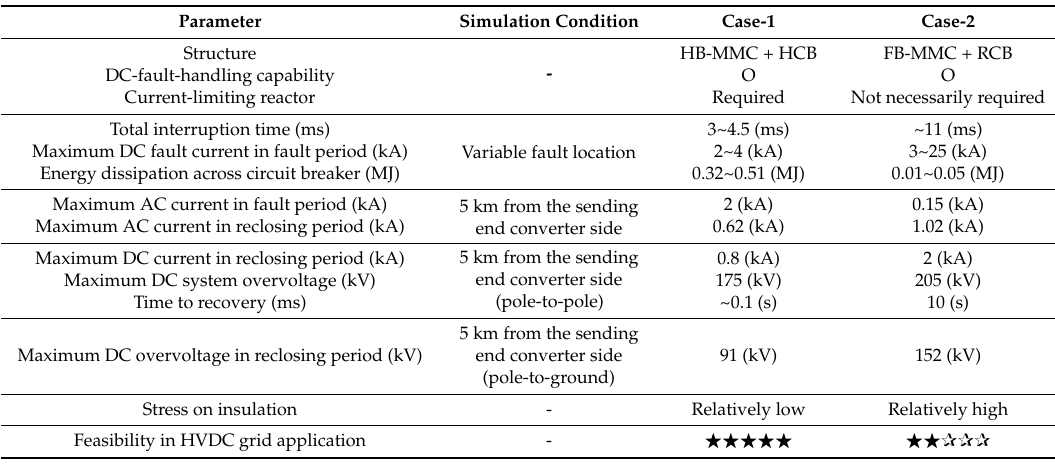
Table 2. Comparison of the two fault-handling